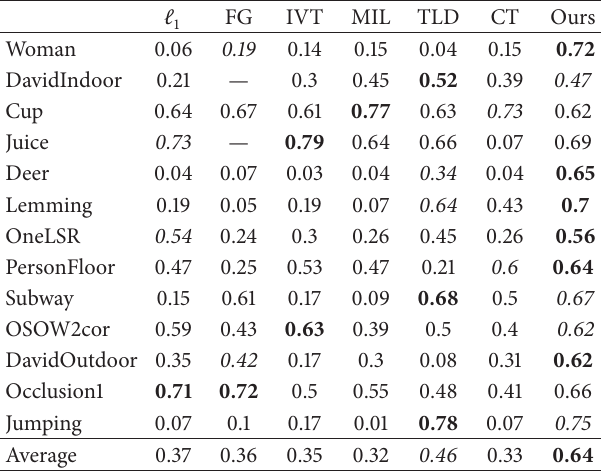
Table 3: Overlapping rate. Bold fonts indicate the best performance while the italic fonts indicate the second best